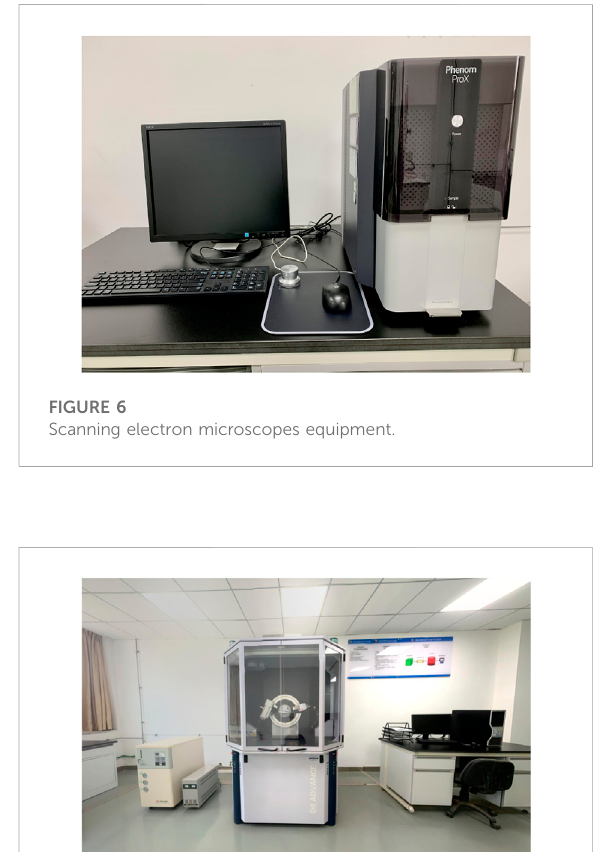
FIGURE 7 X-ray diffractometer.